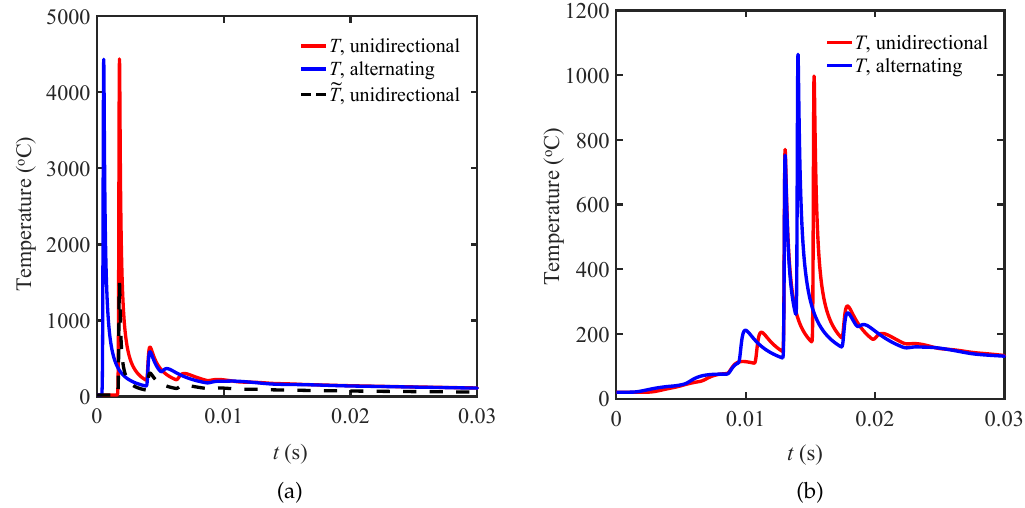
Figure 13. Temperature histories of ( a ) point G1 and ( b ) point